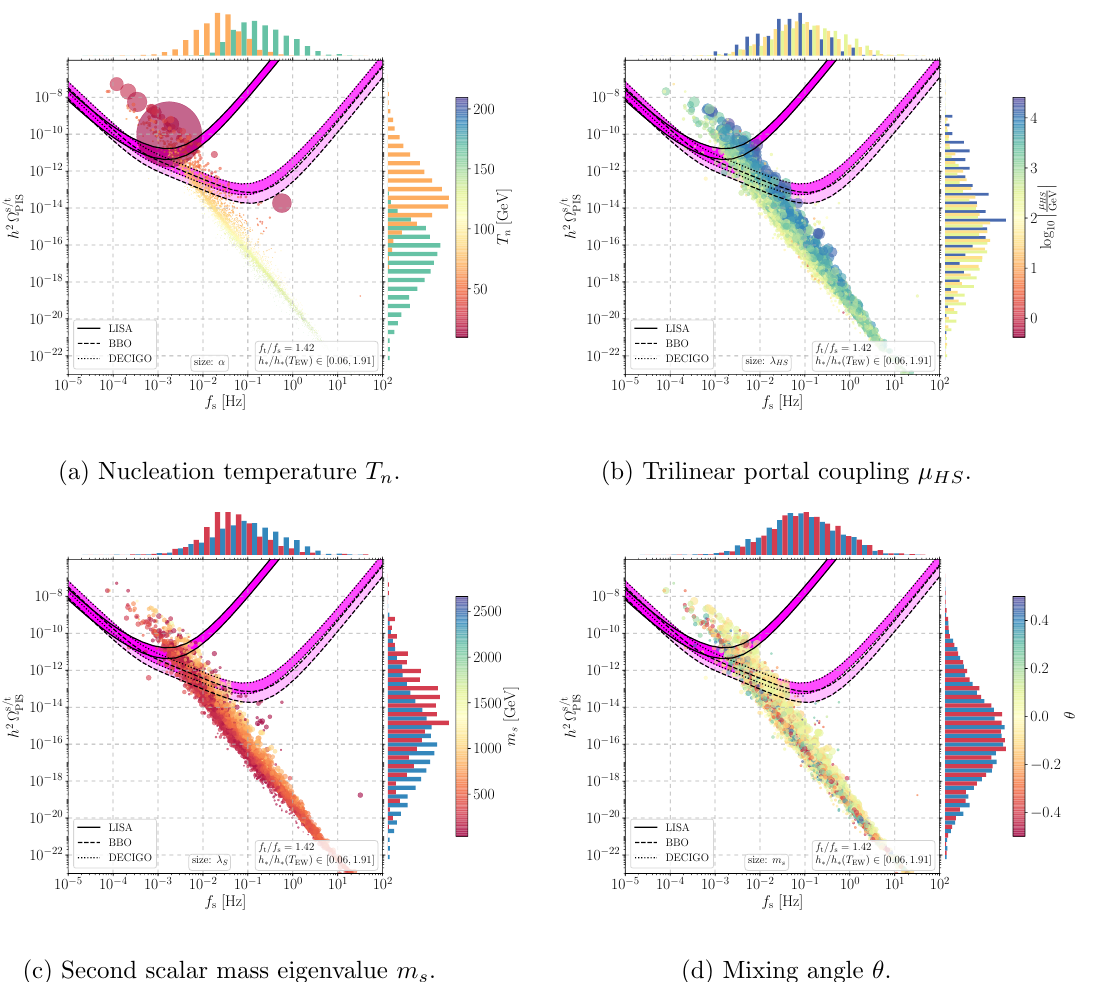
(c) Second scalar mass eigenvalue m s . Figure 3. PISC plots in the f s -(cid:10) s = t plane, including di(cid:11)erent model-parameter variations as PIS indicated by the di(cid:11)erent color codes and point sizes. Panel (a) shows the variation of the nucleation temperature T n (color) and the latent heat (cid:11) (size); in the histograms, we distinguish T n > 100 GeV (green) and T n < 100 GeV (orange). Panel (b) shows the variation of the trilinear coupling (cid:22) HS (color) and the portal coupling (cid:21) HS (size); in the histograms, we distinguish (cid:22) HS > 5 TeV (blue), j j 500 GeV < (cid:22) HS < 5 TeV (green), and (cid:22) HS < 500 GeV (orange). Panel (c) shows the variation j j j j of the scalar mass m s (color) and the self-coupling (cid:21) S (size); in the histograms, we distinguish m s > 200 GeV (blue) and m s < 200 GeV (red). Panel (d) shows the variation of the mixing angle (cid:18) (color) and the scalar mass m s (size); in the histograms, we distinguish (cid:18) > 0 (blue) and (cid:18) < 0 (red).